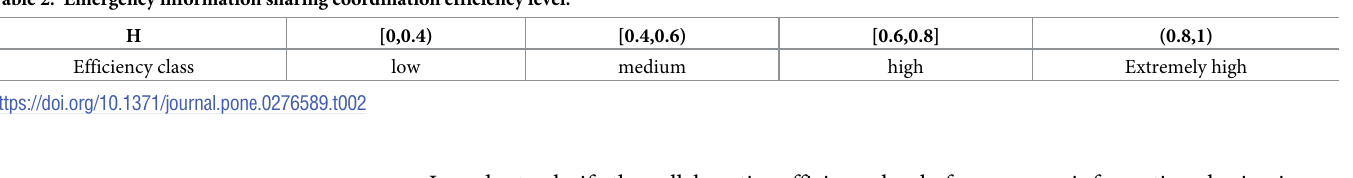
coastal cities, this paper refers to the hierarchical classification method proposed by Su Yi et al. (2018) [30] to divide the H value into 4 levels, as shown in Table 2.